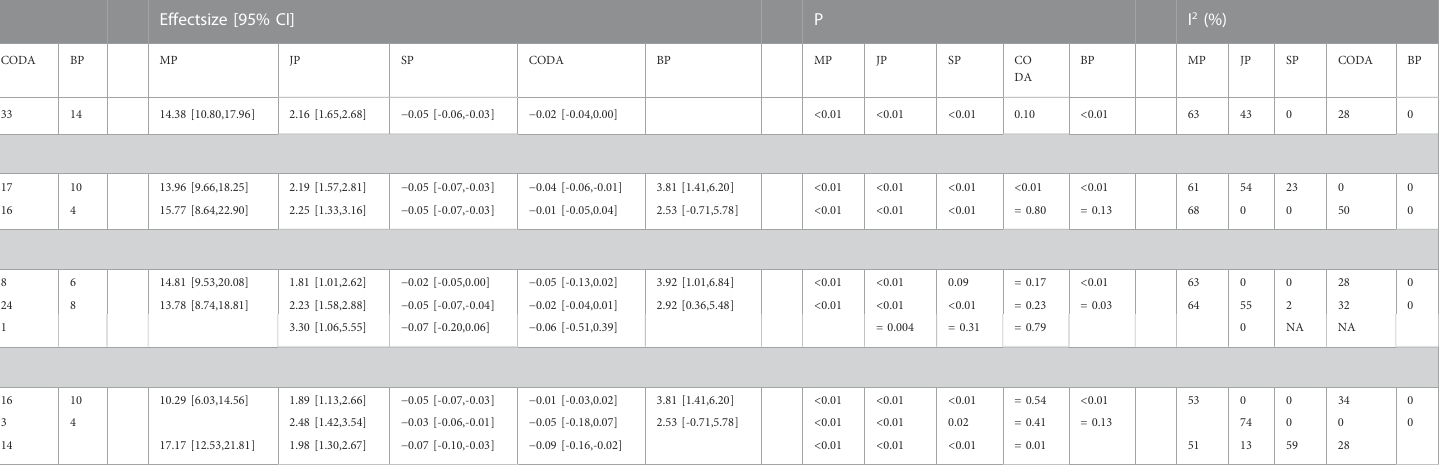
TABLE 5 Study of the effect of BI training on physical performance.